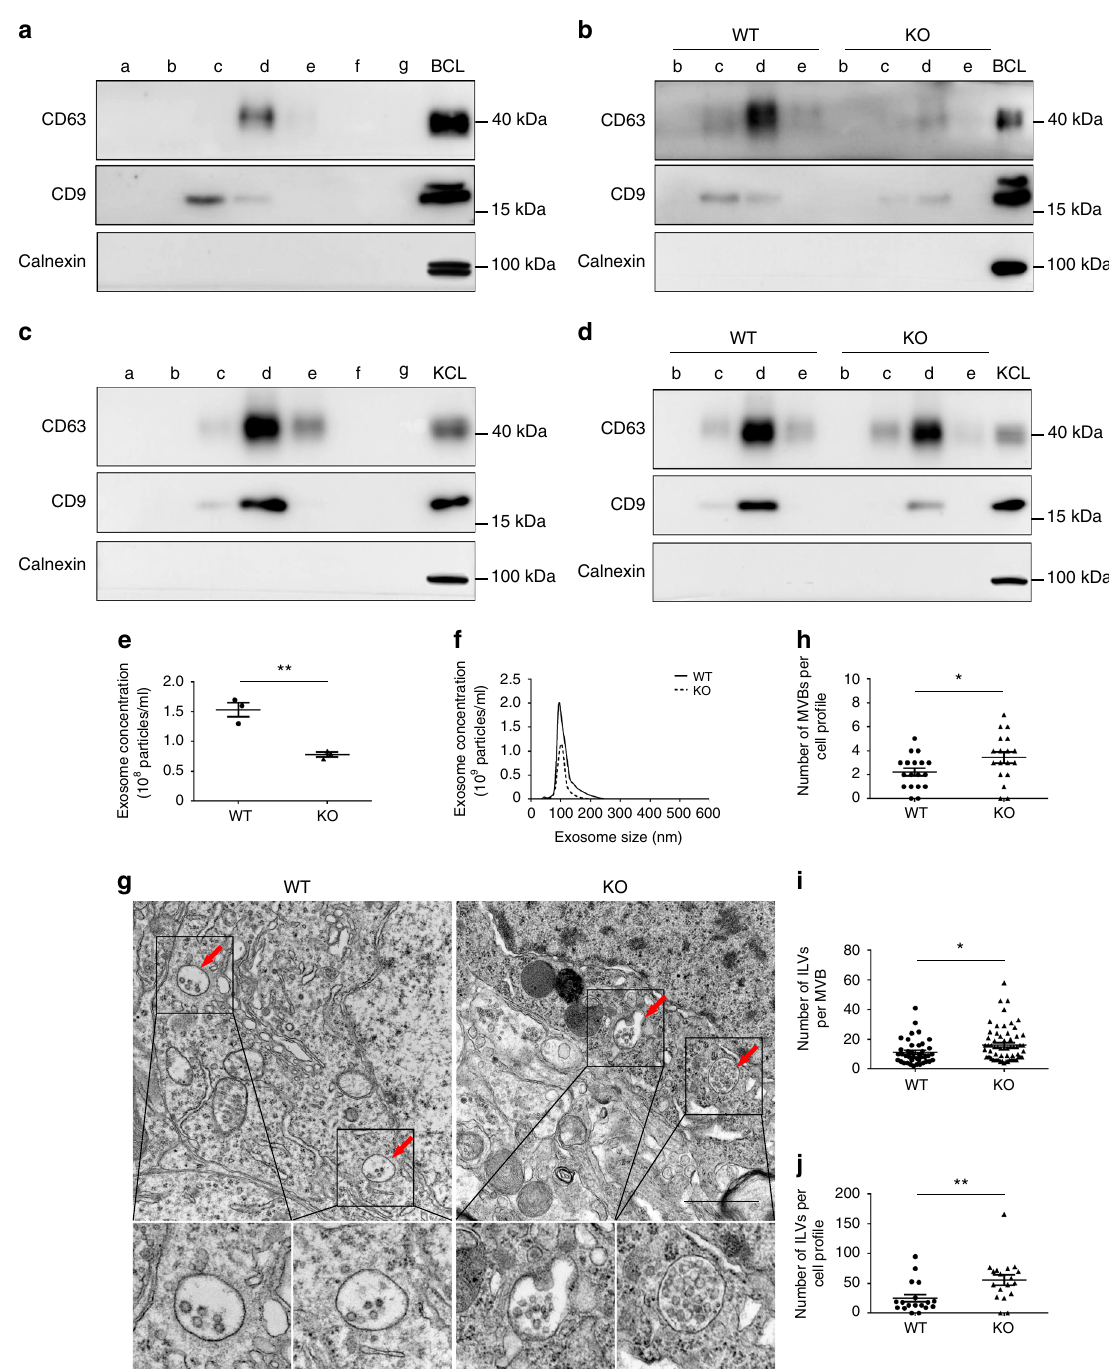
Fig. 3 KIBRA regulates exosome secretion and the multivesicular body (MVB) phenotypes in vivo. a , c Sucrose step gradient fractions a – g isolated from the extracellular space of the brain ( a ) or kidney ( c ) from wild-type (WT) mice were blotted for the exosomal markers CD63, CD9, and Calnexin. The brain cell lysates (BCL) and kidney cell lysates (KCL) were used as controls, respectively. b , d Fractions b – e isolated from the extracellular space of the brain ( b ) or kidney ( d ) from WT and KIBRA-KO mice were blotted for CD63, CD9, and Calnexin. e Quanti fi cation of nanoparticle tracking analysis (NTA) experiments of exosomes isolated from the same volume of serum from KIBRA-KO and WT mice. f Representative NTA traces of exosomes isolated from the same volume of serum from KIBRA-KO and WT mice. g Representative electron microscopic images of hippocampus area in KIBRA-KO and WT mice. Scale bar = 1 μ m. Zooms (lower panels) were ×4.0. Red arrows indicate MVBs containing typical intraluminal vesicles (ILVs). h The number of MVBs per cell pro fi le. i The number of ILVs per MVB. j The number of ILVs per cell pro fi le. ILVs and MVBs in 18 pro fi les of different cells were counted in a blind manner and only MVBs containing typical ILVs were counted. The quanti fi cation results were plotted as dot plots, showing the mean ± SE. * P < 0.05, ** P < 0.01 as determined by two-tailed t